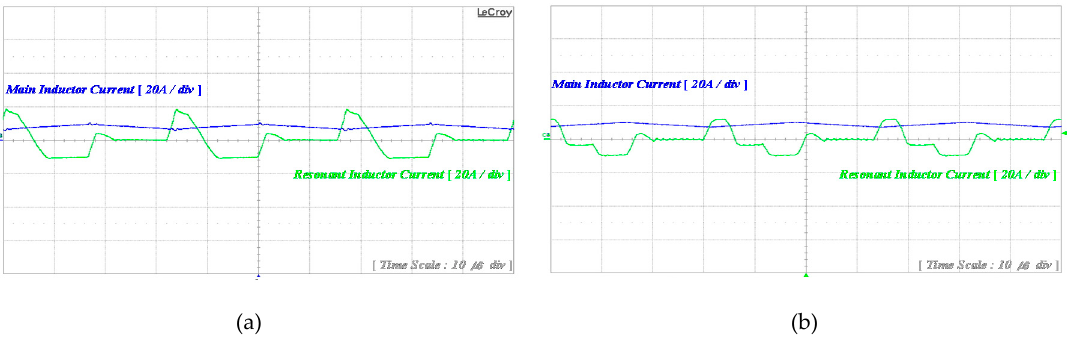
Figure 19. Waveforms of main and resonant inductor current. ( a ) Conventional converter and ( b ) proposed converter.